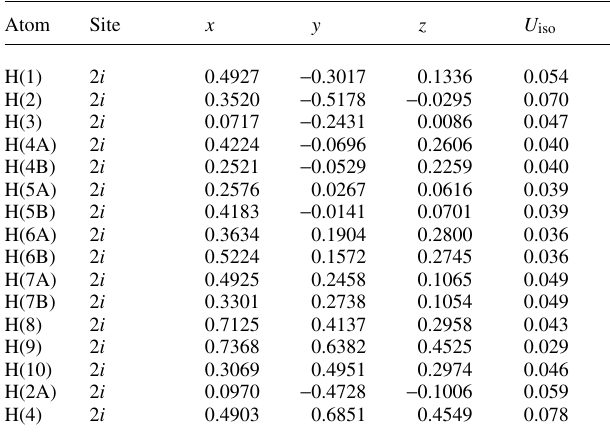
Table 2. Atomic coordinates and displacement parameters (in Å 2 )